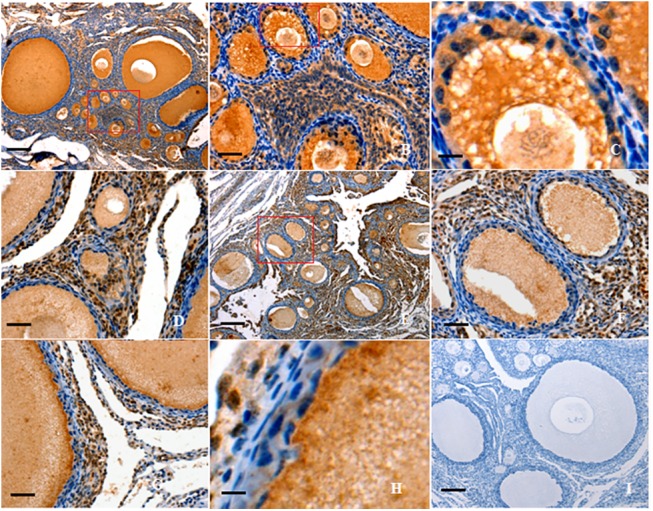
Immunohistochemical analysis of FOXL2 and GDF9 protein expression in the ovarian follicle.Paraformaldehyde-fixed tissue sections were immunostained using anti-chicken FOXL2 (A-D) or anti-chicken GDF9 (E-H) as described above. Panel A, strong staining is observed in all oocytes (OC) and granulosa cells (GCs) within the variously sized follicles (×10). Panel B, the amplified primary follicles and prehierarchical follicles (×40), paralleling the one marked in the box of panel A; Panel C, the amplified small-sized PF follicles with two or three layers of GC(×200), paralleling the one marked in the box of panel B. Panel D, the amplified large PF follicles with more layers of GCs (×40). Panel E, a distinct positive staining was seen in the all follicles observed (×10). Panel F, in parallel to the one marked in the box of panel E, strong staining was observed in OC and GCs (×40). Panel G, the amplified prehierarchical follicle (×40); Panel H, the amplified large PF follicles with more layers of GCs (×200). Panel I, one of the negative control for FOXL2, the sections were immunostained with pre-immune serum, no significant expression was detected (similar negative control for GDF9 is not given here). Negative control sections were prepared with the primary antibody pre-incubated with a blocking peptide for 1 h at room temperature and for 2 h at 4°C. Five birds were used for immunohistochemical analysis and representative microscopic fields were selected. Scale bar = 100 μm.